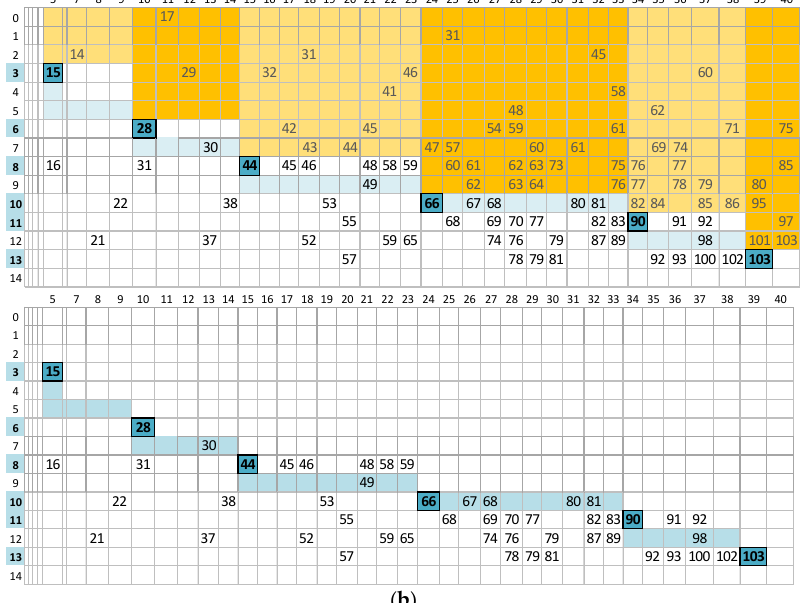
Figure 7. X-tracking and B-reduction: ( a ) an example ( n = 5) of X-tracking for selecting j = 3, 2, 0 and ( b ) an example( n = 15) of X-tracking and B-reduction for selecting j = 13, 11, 10, 8, 6, 3. 4. 0/1-mKP Solving by Multi-DPT-List TSR Plus Unbiased Filtering in Efficient Time